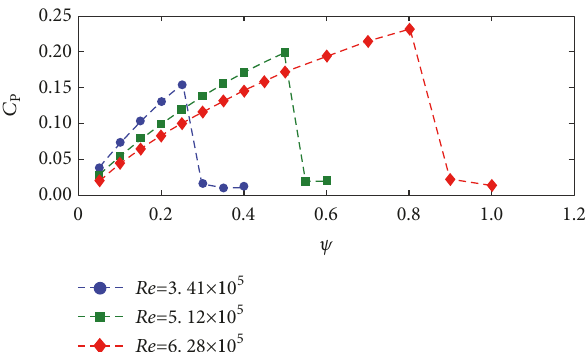
Figure 5: Mean power coefficient versus rotation friction ratio 𝜓 of the passive rotation VAWT with Re =3.41 × 10 5 , 5.12 × 10 5 and 6.82 × 10 5 .